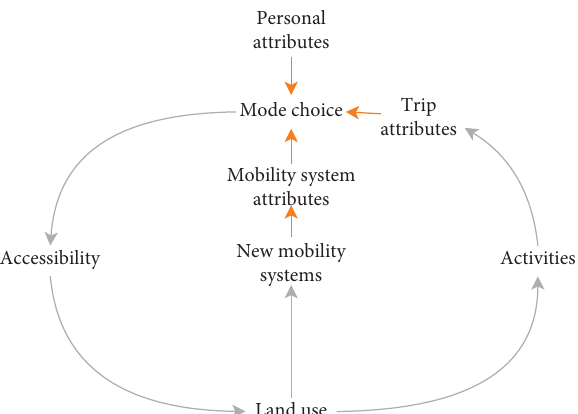
Figure 1: Dominant relationships of the efects of new mobility systems on mode choice. Adaptation from Wegener